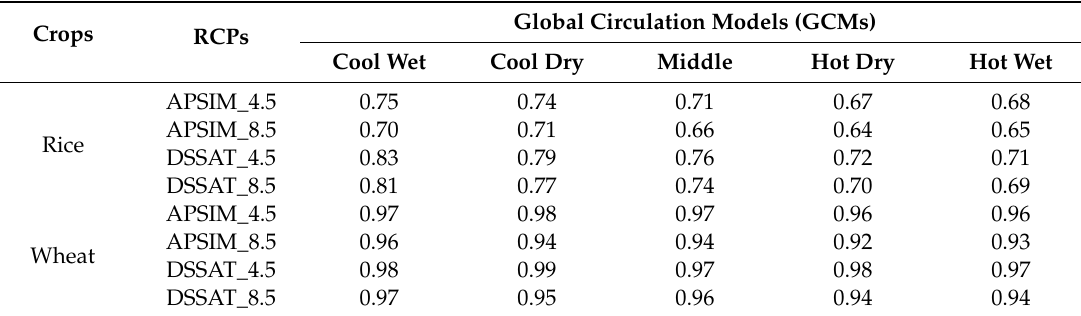
Table 5. Relative yields distribution of modeled crops for current climatic conditions. Global Circulation Models (GCMs) Crops RCPs Cool Wet Cool Dry